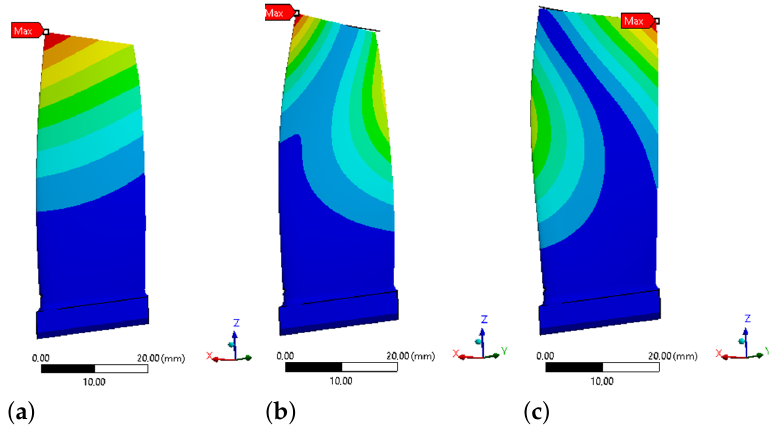
Figure 7. Free vibration modes of the blade: ( a ) I-st, ( b ) II-nd and ( c ) III-rd mode (SAL analysis) (results scaled to 1 mm deformation, where blue means 0 mm and red means 1 mm).